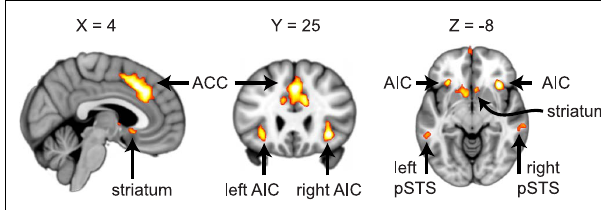
FIGURE 1 | Regions of interest involved in empathy (ACC, bilateral AIC), social significance (bilateral pSTS) and reward processing (striatum). Cross-sections of the brain are shown at MNI coordinates X = 4, Y = 25, and Z =− 8.Voxels shown exceed an uncorrected threshold of Z > 3.1 ( p < 0.001) on an F -test over the averaged pre- and post-interaction DOT trials (also see Figure 2 and Materials and Methods).